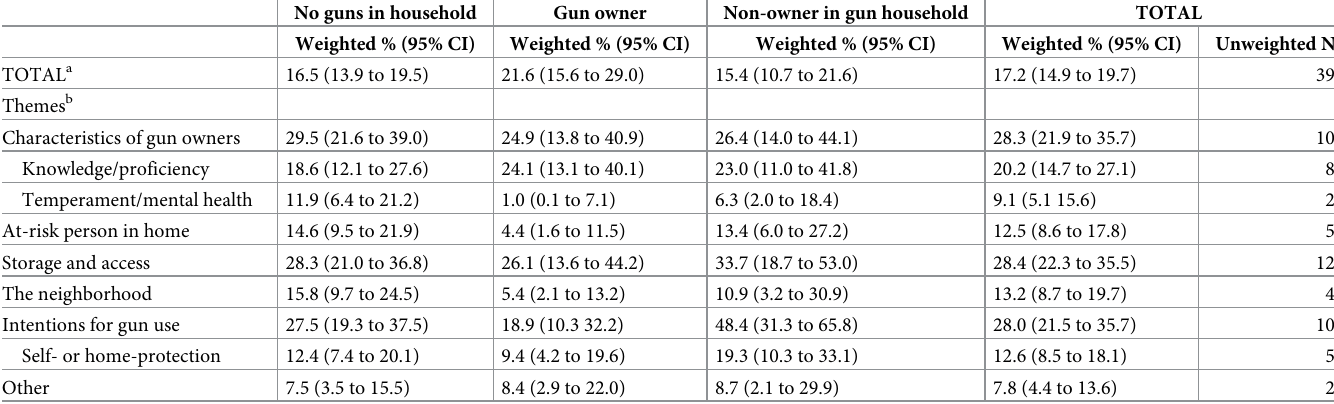
Table 4. Percentage of respondents who reported “it depends” whether guns make homes safer or more dangerous and factors on which it depends, by firearm own- ership status. The home scenario. No guns in household